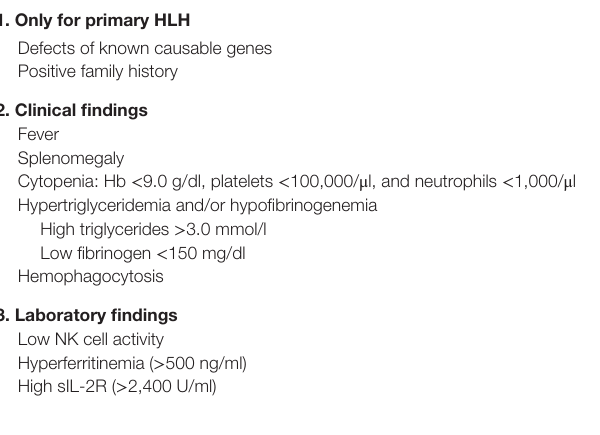
TABLe 1 | Diagnostic criteria of